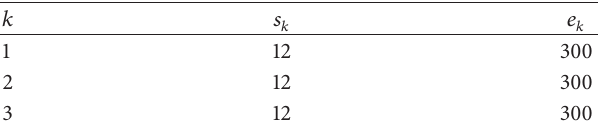
Table 1: Information of 3 berths.